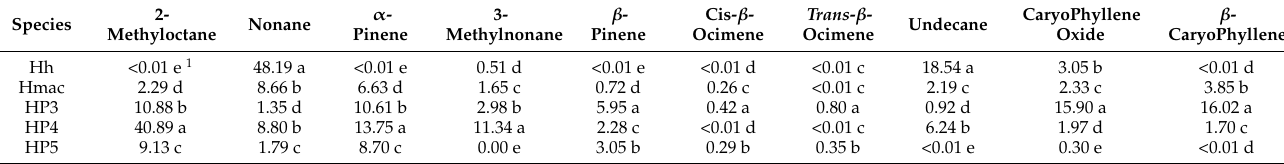
Table 3. Mean concentrations (%) of 2-methyloctane, nonane, α -pinene, 3-methylnonane, β - pinene, cis- β -ocimene, trans - β -ocimene, undecane, caryophyllene oxide, and β -caryophyllene obtained from the six